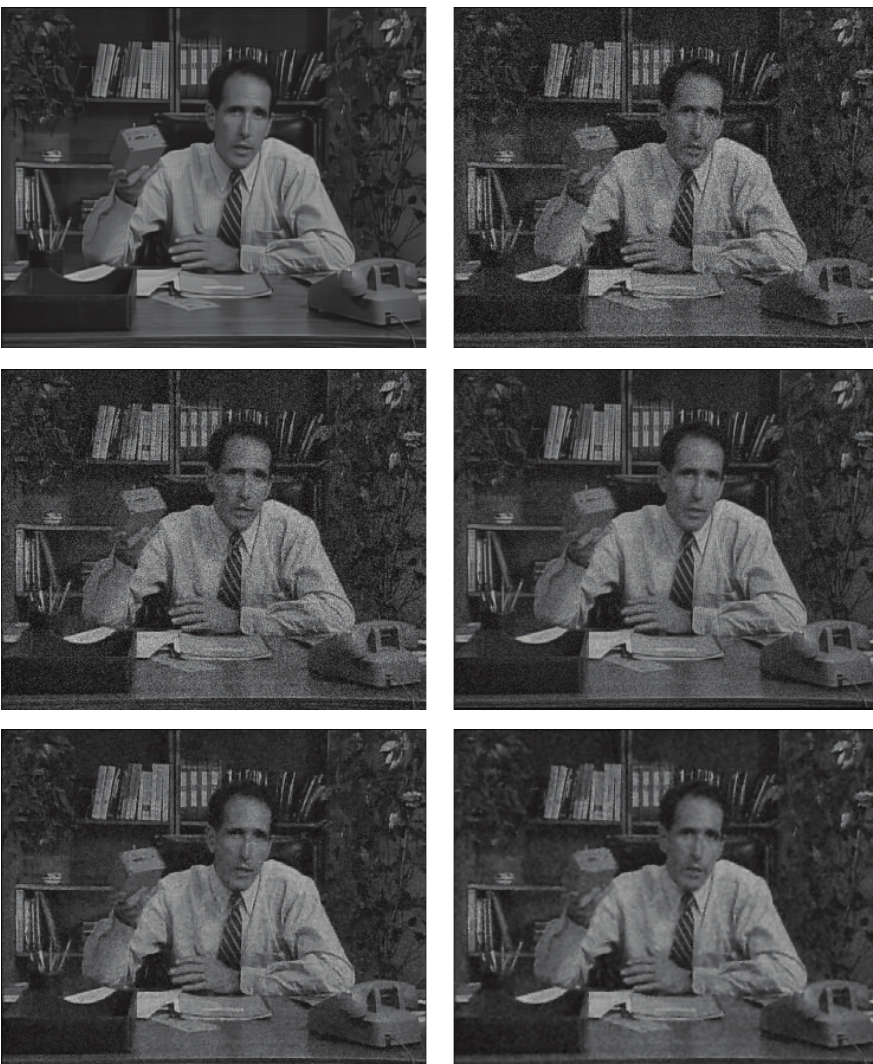
Figure 4: Visual comparison of different algorithms for frame 5 of Salesman sequence. From left to right and from top to bottom: original frame, noisy frame ( 𝜎 𝑛 = 15 ), result of [26] algorithm, result of [27] algorithm, result of [28] algorithm, and result of the proposed